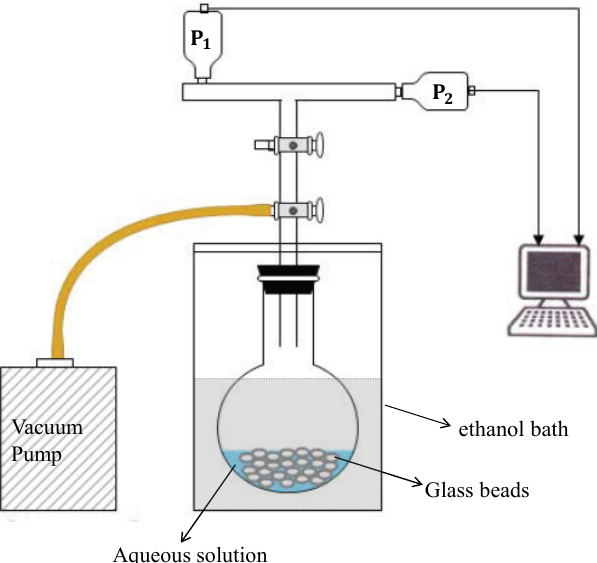
Figure 1. Setup for total gas phase pressure measurements of aque- ous organic solutions at room temperature and